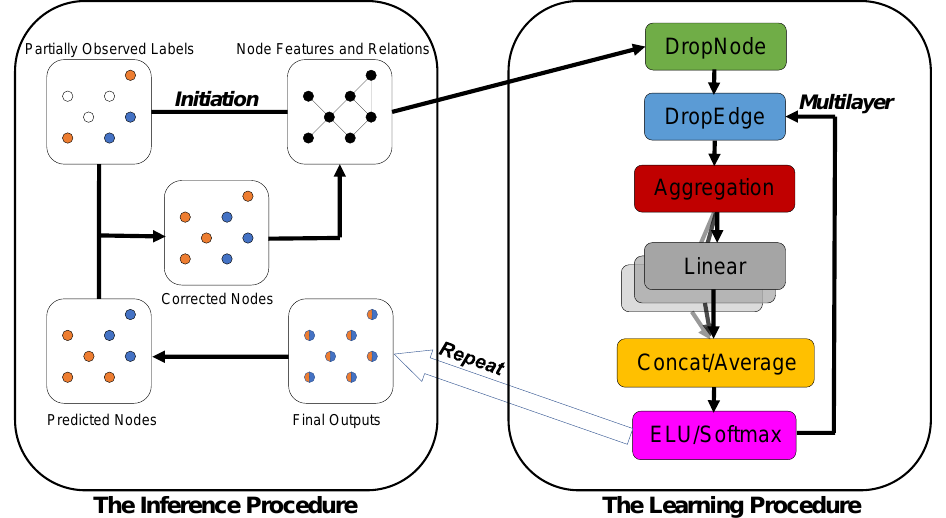
Figure 1. The architecture of GRNN. Given the node features and relations, GRNN combines partially observed labels in the initial learning procedure, which is equivalent to the benchmark neural network. In the inference procedure, the predicted nodes are the index value of the maximum value of the final outputs, and the corrected nodes are corrected using the predicted nodes through partially observed labels. Finally, GRNN combines the corrected nodes and partially observed labels in the next learning